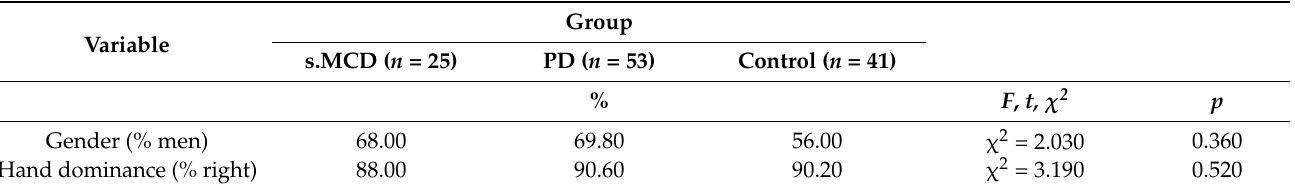
Table 1. Comparison of group demographic characteristics and medical status of the PD patients with (s.MCD group) and without (PD group) mild cognitive impairment based on their CF feature and healthy